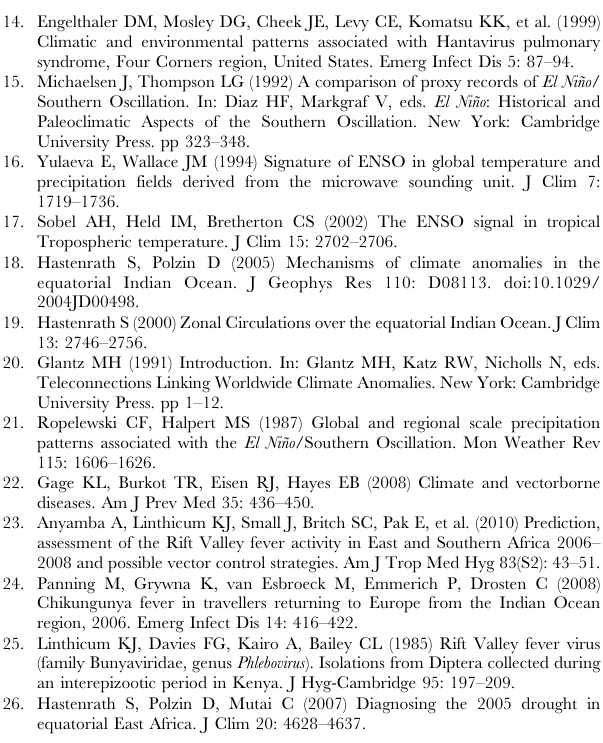
(red lines) for sites with reported Rift Valley fever activity. Dotted line represents when the first case of Rift Valley fever was identified at each location. Each of the outbreak locations was preceded by above-normal rainfall for 3–4 months. Figure S4 Distribution of 2004–2010 chikungunya out- breaks in relation to human population density. Each symbol represents the year(s) when an outbreak was reported at a specific geographic location. Most chikungunya activity has occurred in locations with high population densities ( . 500 people per square